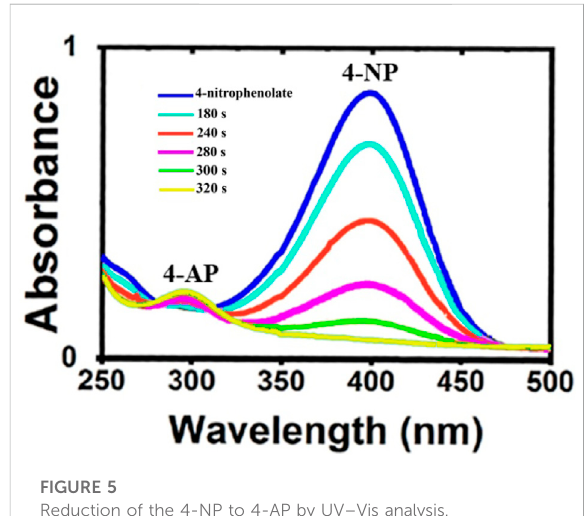
FIGURE 5 Reduction of the 4-NP to 4-AP by UV – Vis